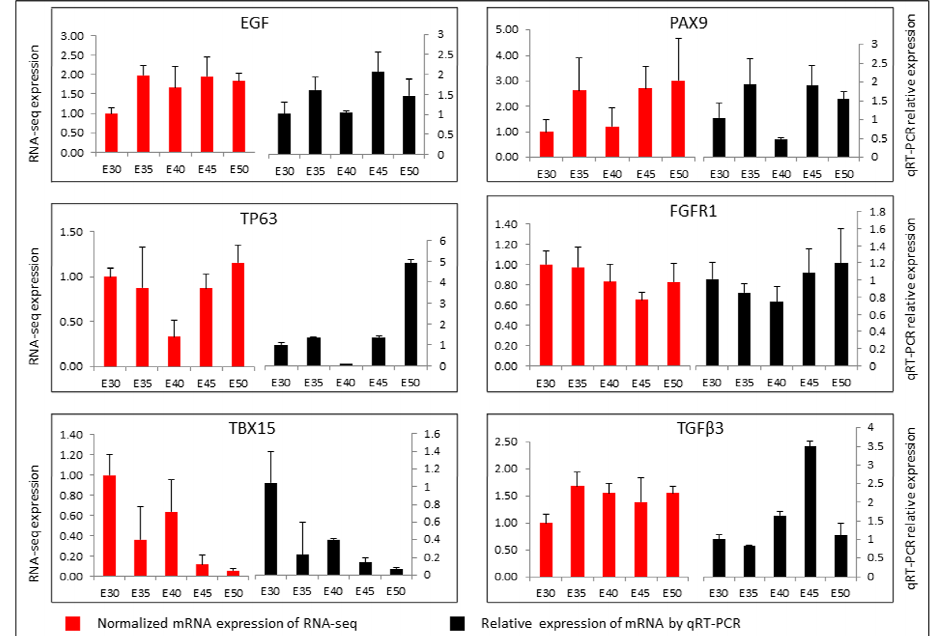
Figure 6. Expressions of the six mRNAs using RNA-Seq and qRT-PCR. All the data are shown as mean ± SE.